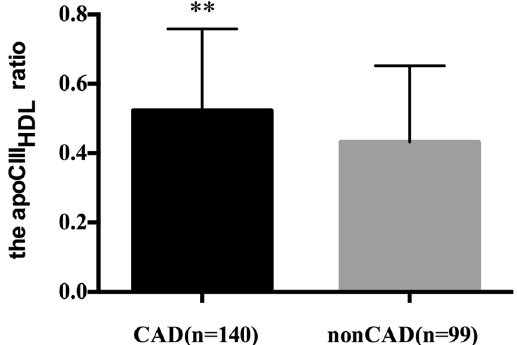
Figure 2. The apoCIII HDL ratio (apoCIII HDL over plasma apoCIII) between CAD (n = 140) and nonCAD (n = 99) patients. Data are expressed as mean ± SD. ApoCIII HDL indicates apolipoprotein CIII in apoB-depleted plasma; apoB, apolipoprotein B; CAD, coronary artery disease. ** P < 0.01.